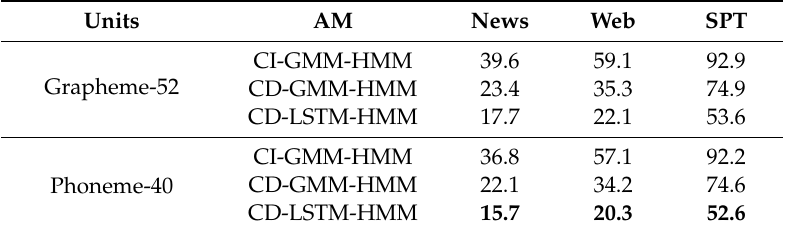
Table 3. Word error rate (%) of the grapheme unit and the phoneme unit. Units AM News